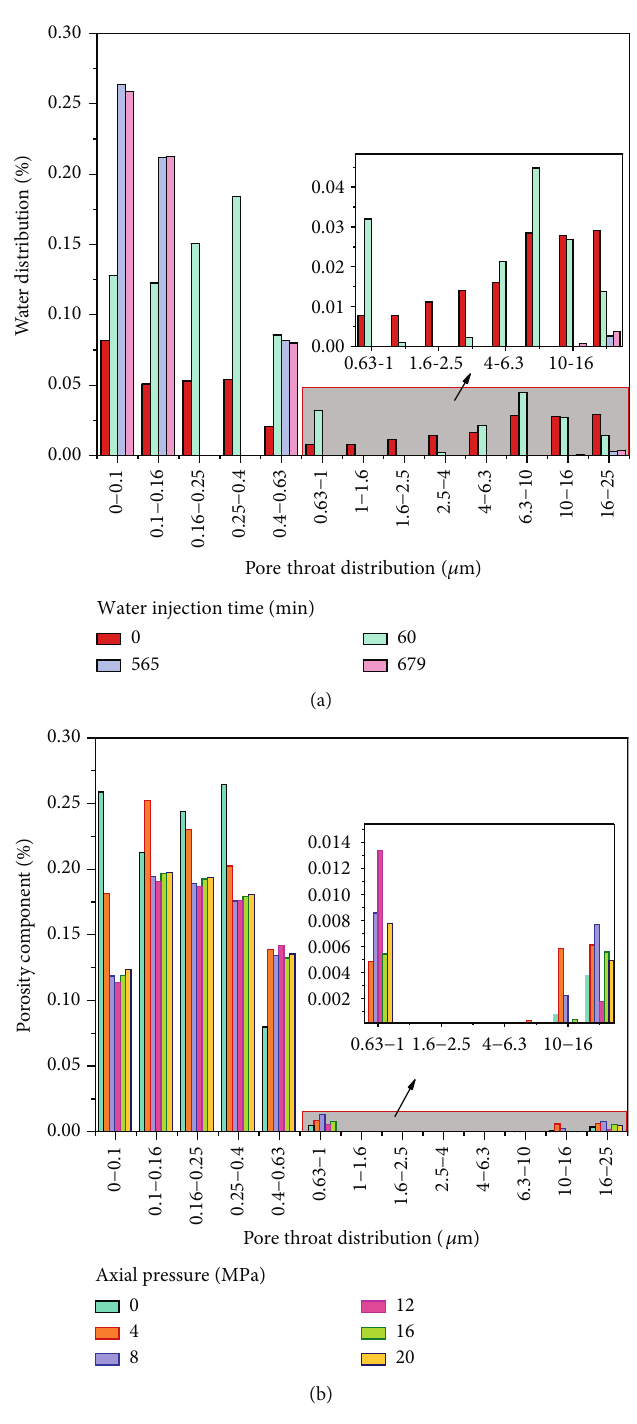
Figure 13: The pore throat distribution of the sample. (a) Water injection process. (b) Triaxial compression